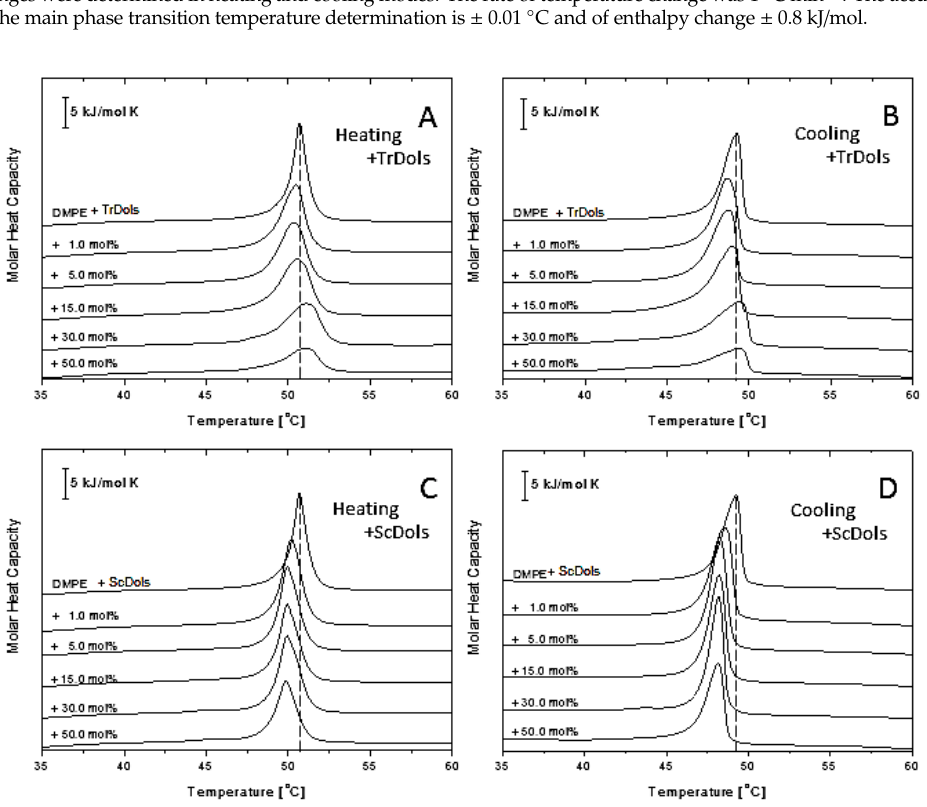
Figure 9. Influence of dolichols on thermal properties of 1,2-dimyristoyl- sn -glycero-3-phosphatidylethanolamine (DMPE) membranes. Di ff erential scanning calorimetry (DSC) of multilamellar vesicles obtained in the heating ( A , C ) and cooling ( B , D ) modes for TrDols ( A , B ) and ScDols ( C , D ) are shown. Scans were obtained at the rate of 1 ◦ C min − 1 : representative scans of three independent runs are shown. Table 5. Thermodynamic parameters of fully hydrated multilamellar 1,2-dimyristoyl- sn -glycero-3-phosphatidylethanolamine (DMPE) liposomes supplemented with S. cerevisiae or T. reesei dolichols.